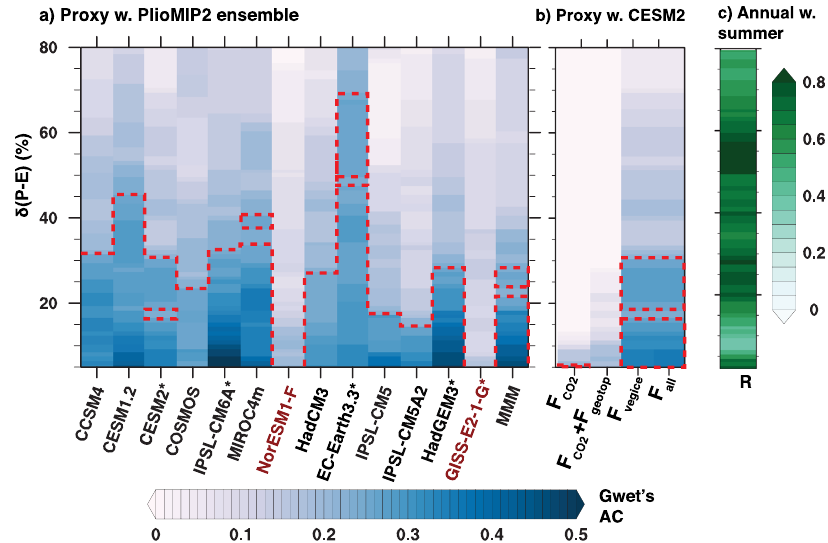
Fig. 2 Degree of agreement between mid-Pliocene proxy hydroclimate indicators and simulations. Proxy-model fi t is assessed using a measure of categorical agreement between two datasets called Gwet ’ s AC (unitless). For a given % threshold of simulated changes in precipitation minus evaporation ( δ ( P – E )) relative to the preindustrial, higher (lower) values indicate that proxies and models agree (disagree) that given locations are wet, dry, or neutral. The area within the dashed line indicates statistically signi fi cant agreements. a Gwet ’ s AC agreement between individual models, Multimodel mean (MMM), and proxies at different thresholds. CMIP6 models are identi fi ed with asterisks. b Agreement between proxies and simulated δ ( P – E ) in response to single or combined climate forcings ( F all ) from changes of CO 2 ( F CO2 ), tectonics ( F geotop ), and vegetation and ice sheets ( F vegice ). c Gwet ’ s AC agreement between annual and boreal summer averages at proxy sites for PlioMIP2 ensemble